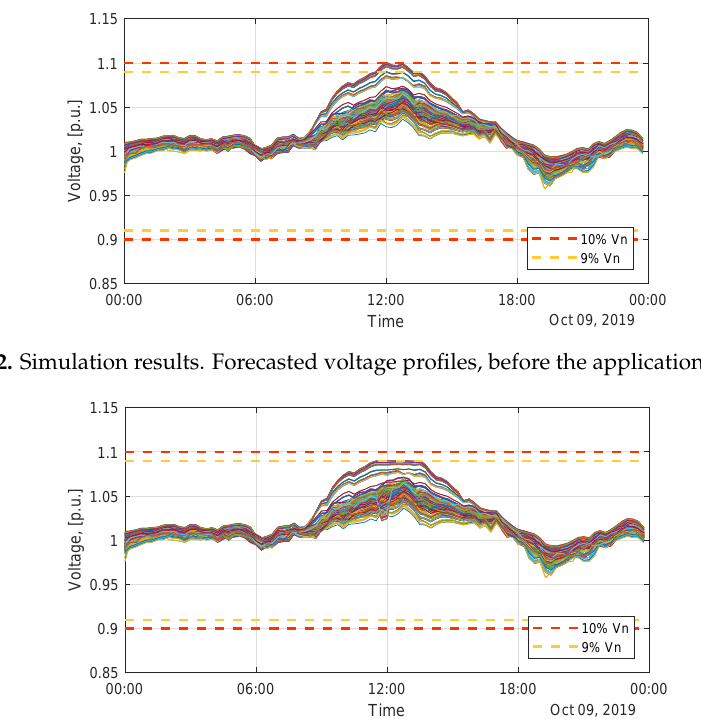
Figure 13. Simulation results. Forecasted voltage profiles, after the application of the LVC.